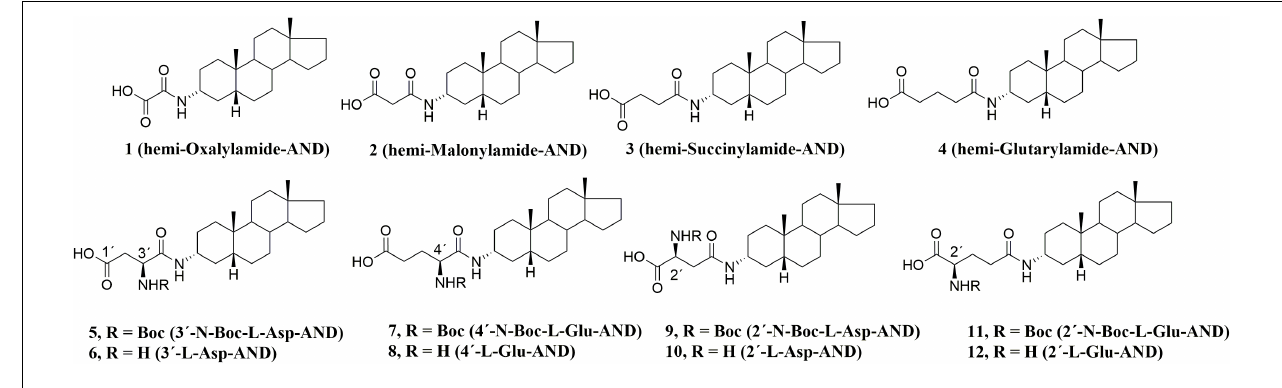
FIGURE 2 | Pregnanolone 3-glutamate-like compounds 1–12.